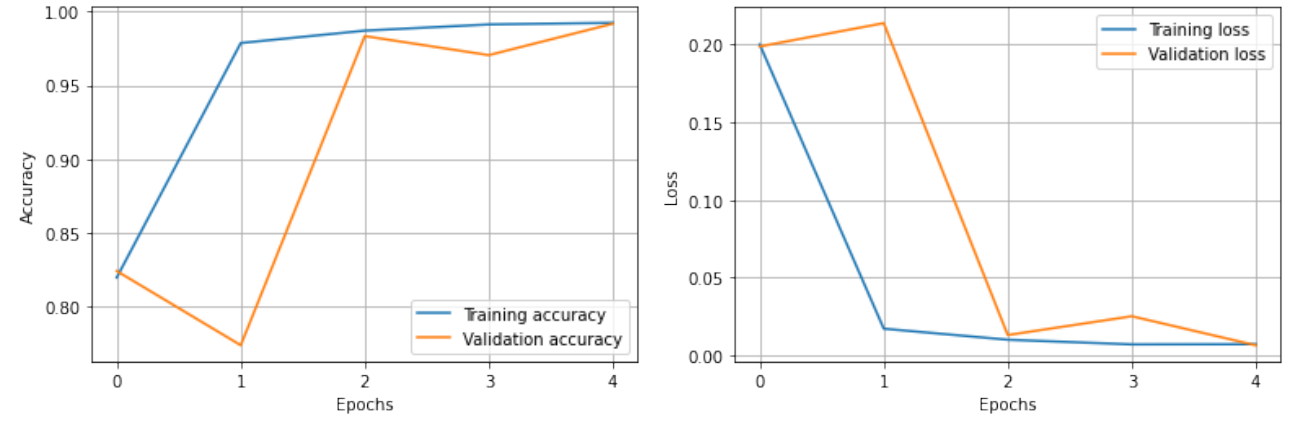
Figure 7. Training and validation loss accuracy changes at every epoch during training.